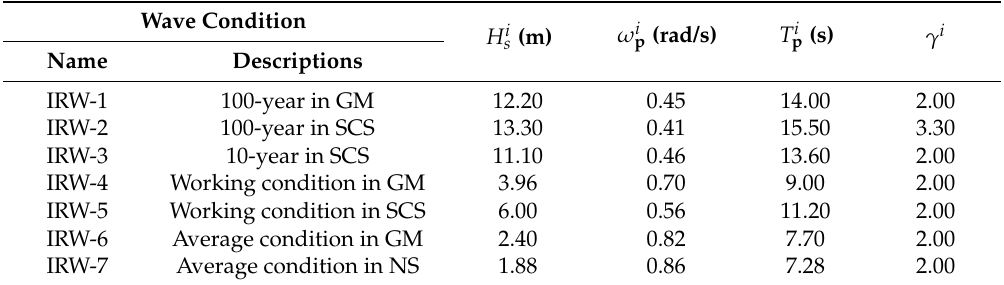
Table 4. Characteristic wave parameters of seven irregular wave sea states.